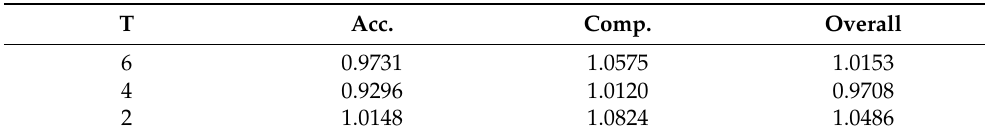
Table 5. Ablation study on the number of Transformer